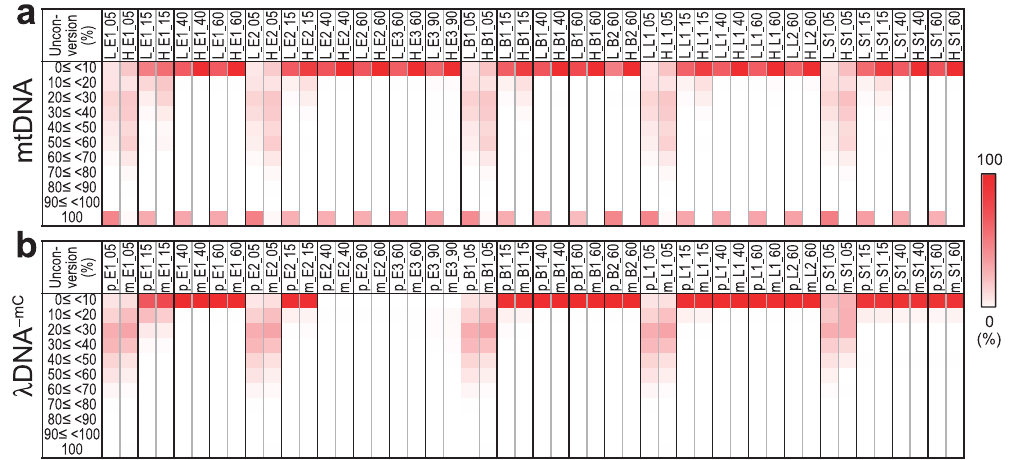
Figure 2. Heat map of distributions of reads acquired from next-generation bisulfite sequencing. Three independent preparations of ESC mitochondrial nucleic acid (mtNA) (E1, E2 and E3), two independent preparations of brain mtNA (B1 and B2), two independent preparations of liver mtNA (L1 and L2) and a preparation of synthetic mtDNA (S1) were subjected to bisulfite conversion for 5, 15, 40, 60 and 90 min (5, 15, 40, 60 and 90) and a total of 24 bisulfite-converted samples (Table 1) were deep-sequenced. Reads were sorted to corresponding samples with distinctions between L stands (L) and H strands (H) of mtDNA ( a ), and between plus strands (p) and minus strands (m) of spiked λ DNA − mC ( b ). Unconversion rates of cytosines in each read were calculated from statuses (converted or unconverted) of all cytosines in the read, and were expressed as percentages. Reads were then categorised with 10% increments of unconversion rates, and distributions of the reads in each increment block were calculated as percentages and are presented in heat maps; colour changes from white to red indicate from 0% to 100%. Calculated percentages of read distributions in increment blocks for each read assembly are shown in Supplementary Fig.